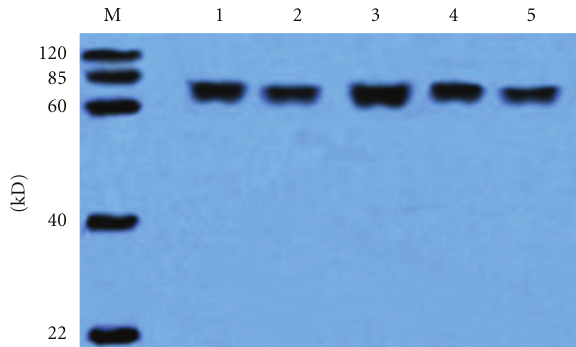
Figure 1: Western blotting results of the five peptides-BSA to the antibodies against the parent proteins, respectively.